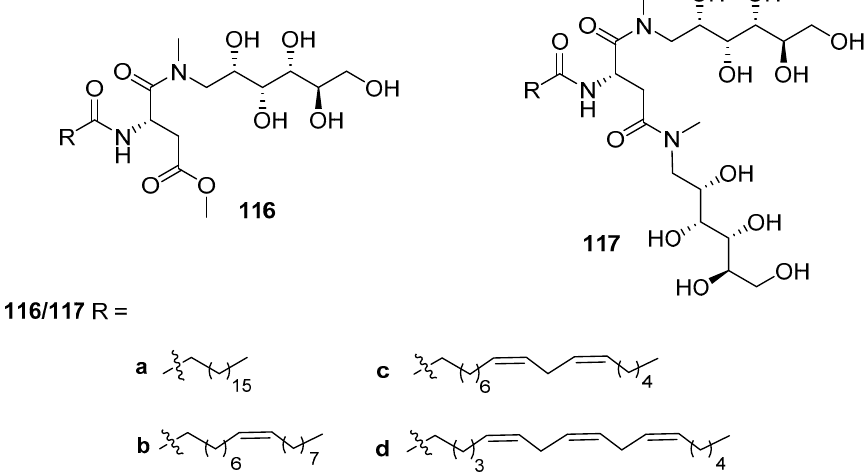
Figure 68. Structures of eight glycolipids containing aliphatic tails with increasing degree of unsaturation [123].